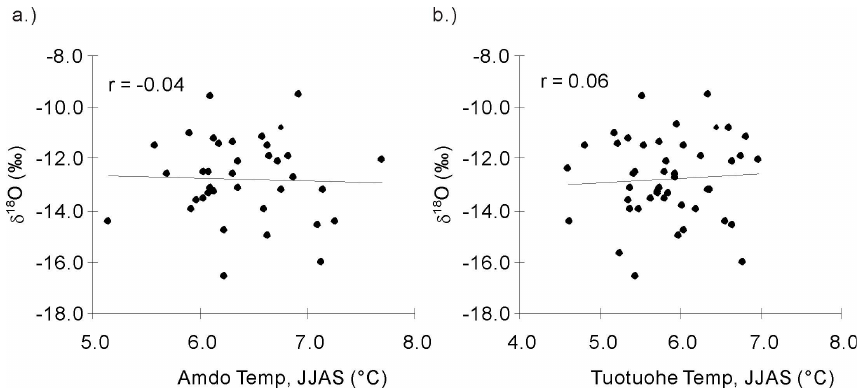
Fig. 5. Scatterplot of annual average δ 18 O values and average JJAS temperature recorded at Amdo (1966–2003) and Tuotuohe (1958–2003) meteorological stations.